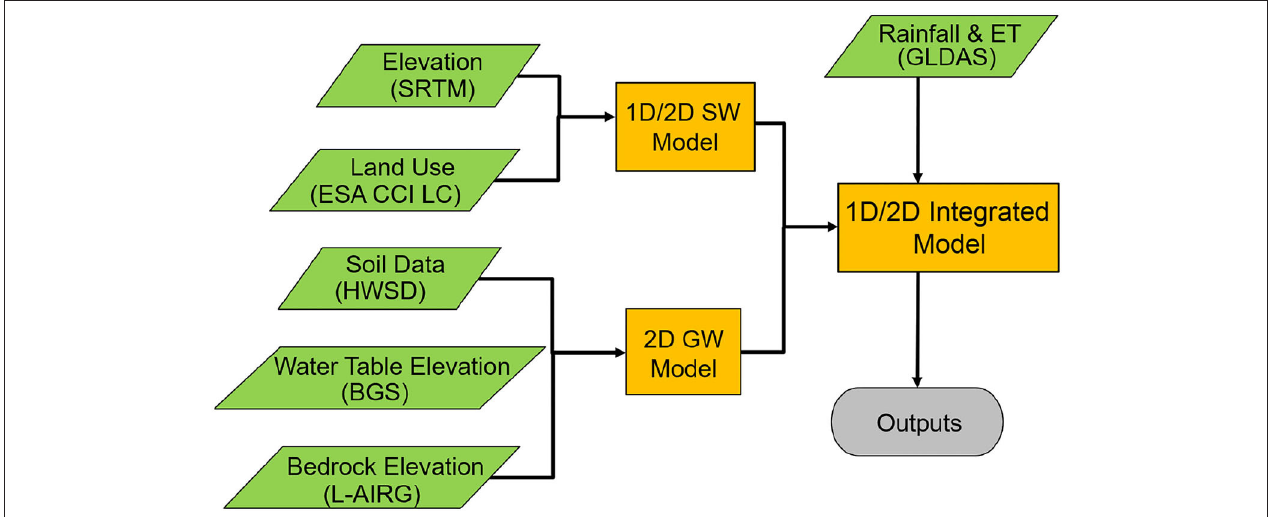
FIGURE 1 | ICPR model process with input data specified (adapted from Saksena et al.,